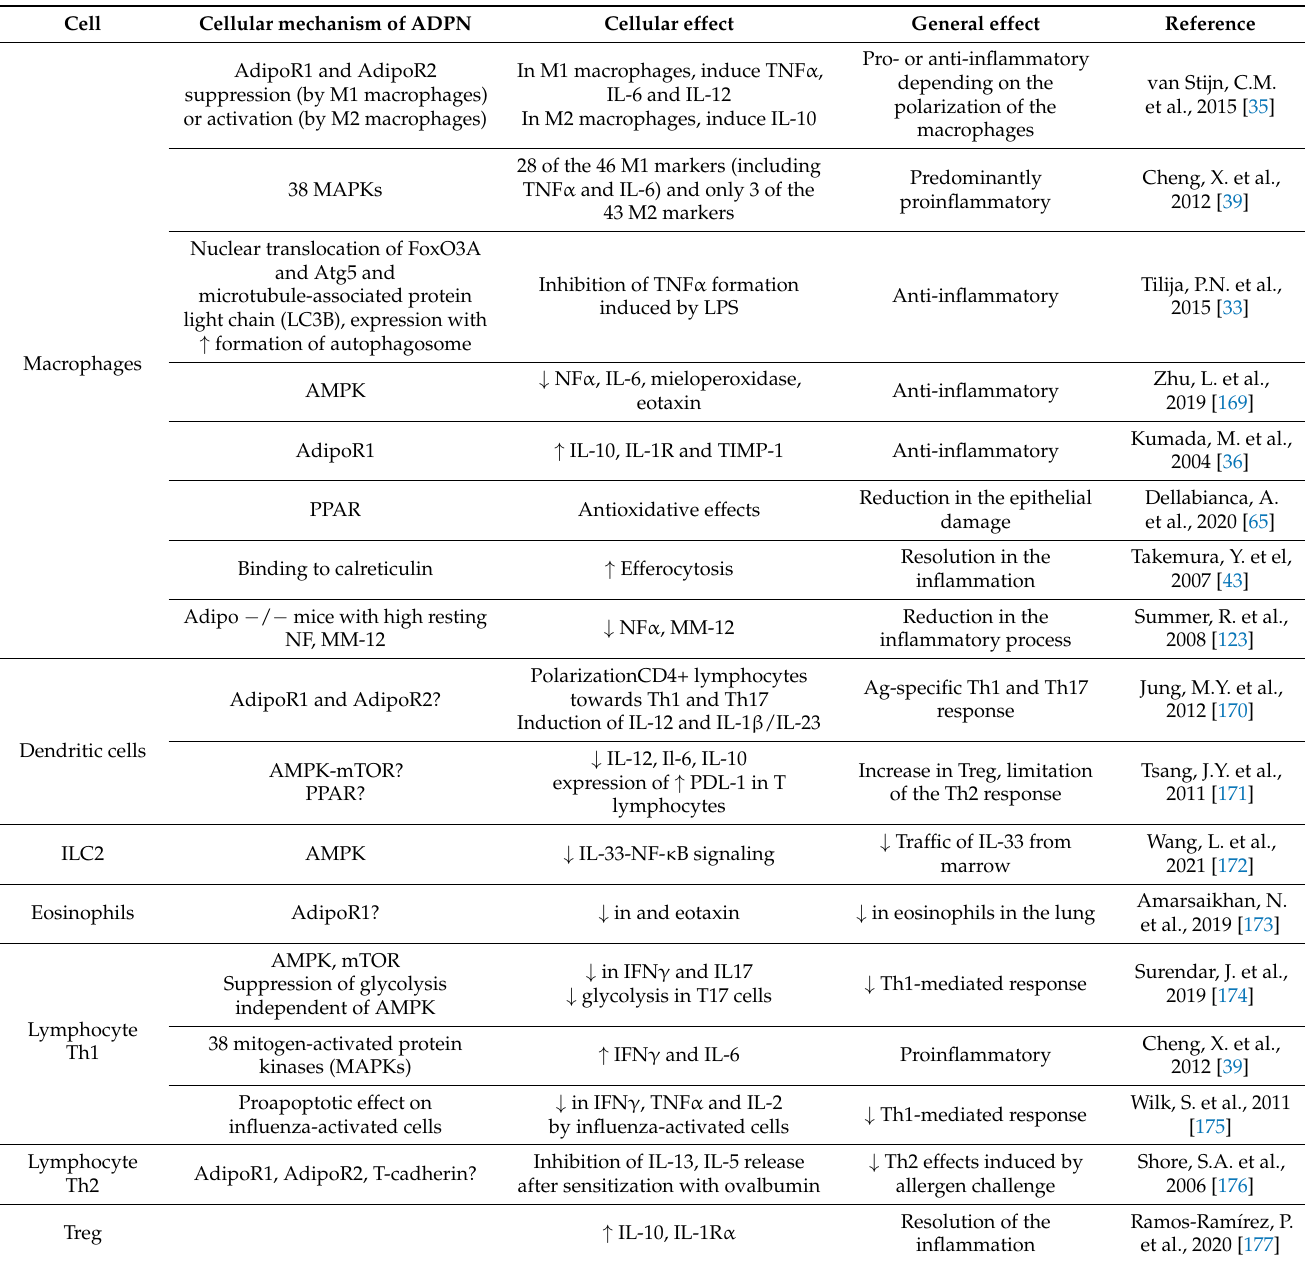
Table 2. Cellular mechanisms of adiponectin relevant for